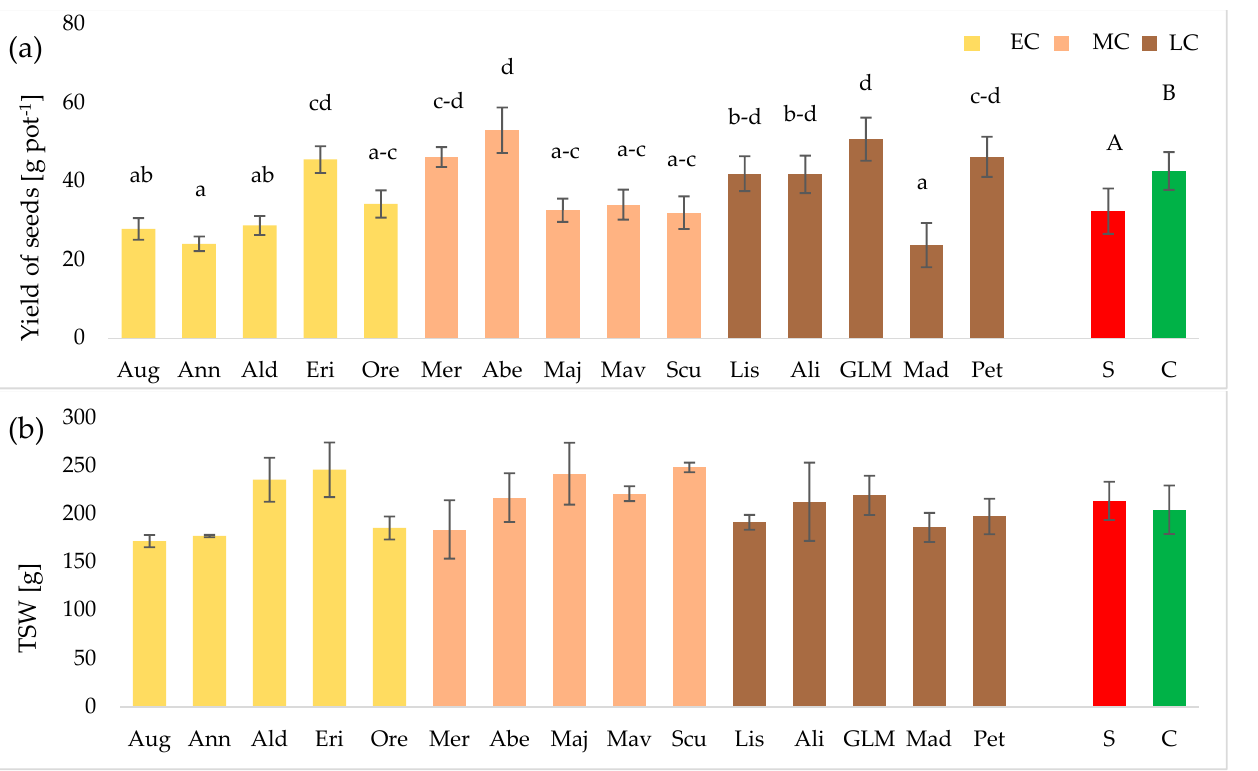
Figure 3. Yield of seeds ( a ) and thousand seed weight (TSW) ( b ) of soybean depending on the cultivar (n = 6) and cold stress (n = 45); Cultivars: Augusta (Aug), Annushka (Ann), Aldana (Ald), Erica (Eri), Oressa (Ore), Merlin (Mer), Abelina (Abe), Maja (Maj), Mavka (Mav), Sculptor (Scu), Lissabon (Lis), Aligator (Ali), GL Melanie (GLM), Madlen (Mad), Petrina (Pet); EC—very early and early cultivars, MC—medium–early cultivars, LC—late and very late cultivars. Different lowercase letters indicate significant differences between cultivars, different uppercase letters—between treatment (cold stress (S) and control (C)) according to the Tukey test ( p = 0.05); ± SD.